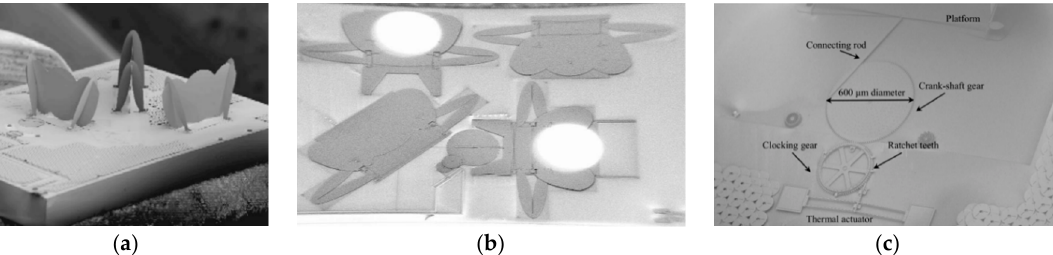
Figure 28. A three-dimensional miniature FTS based on thermal actuator: ( a ) After assembly completion; ( b ) before assembly; ( c ) actuator structure. (Reprinted with permission from References [52,53] SPIE).